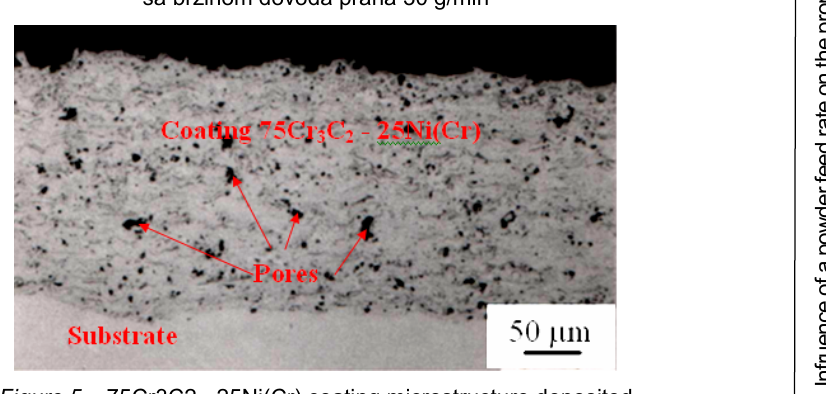
Figure 5 – 75Cr3C2 - 25Ni(Cr) coating microstructure deposited with the powder feed rate of 30 g/min Slika 5 – Mikrostruktura 75Cr3C2 - 25Ni(Cr) prevlake deponovane sa brzinom dovoda praha 30